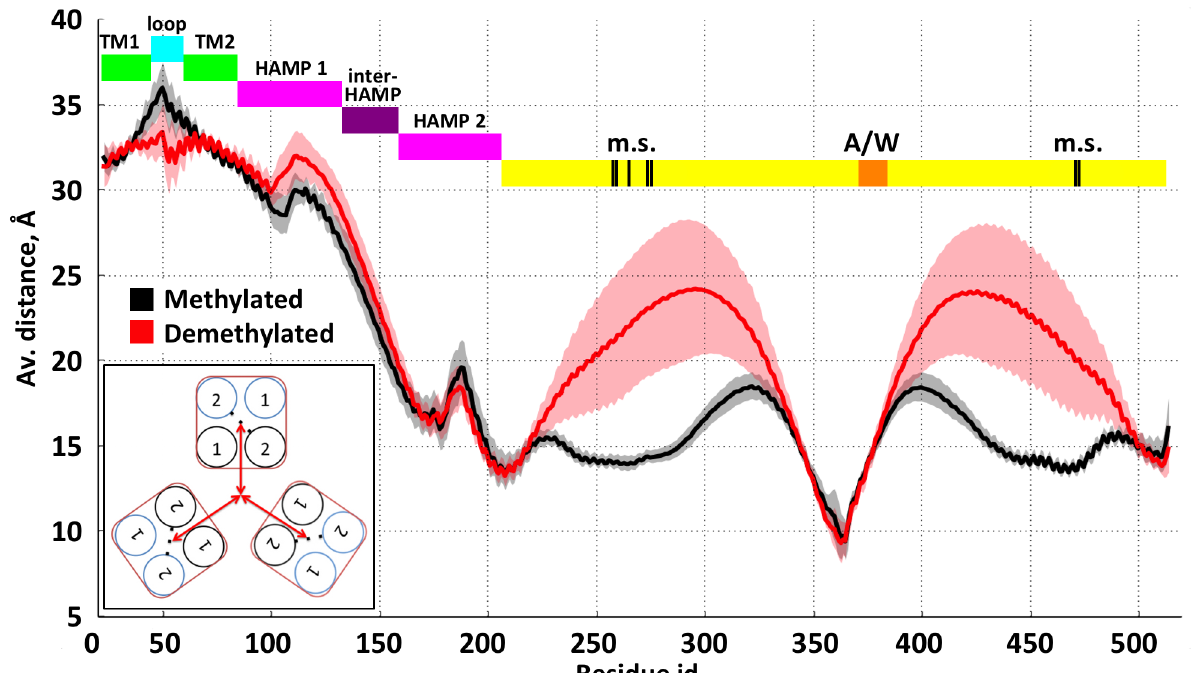
Fig 5. Inter-dimeric distances for related residues of the transducer. Distances were calculated as an average over the three dimers for the methylated (black) and demethylated (red) states, shaded areas representing the standard deviation. The distance is measured between the center of mass (COM) of two related residues in one dimer and the COM of the six respective residues in the trimer-of-dimers (see inset on the lower left). The domains of the complex are depicted in colored bars; m.s and A/W indicate methylation sites and binding sites for CheA/CheW, respectively. Representative distance trajectories are depicted in S7